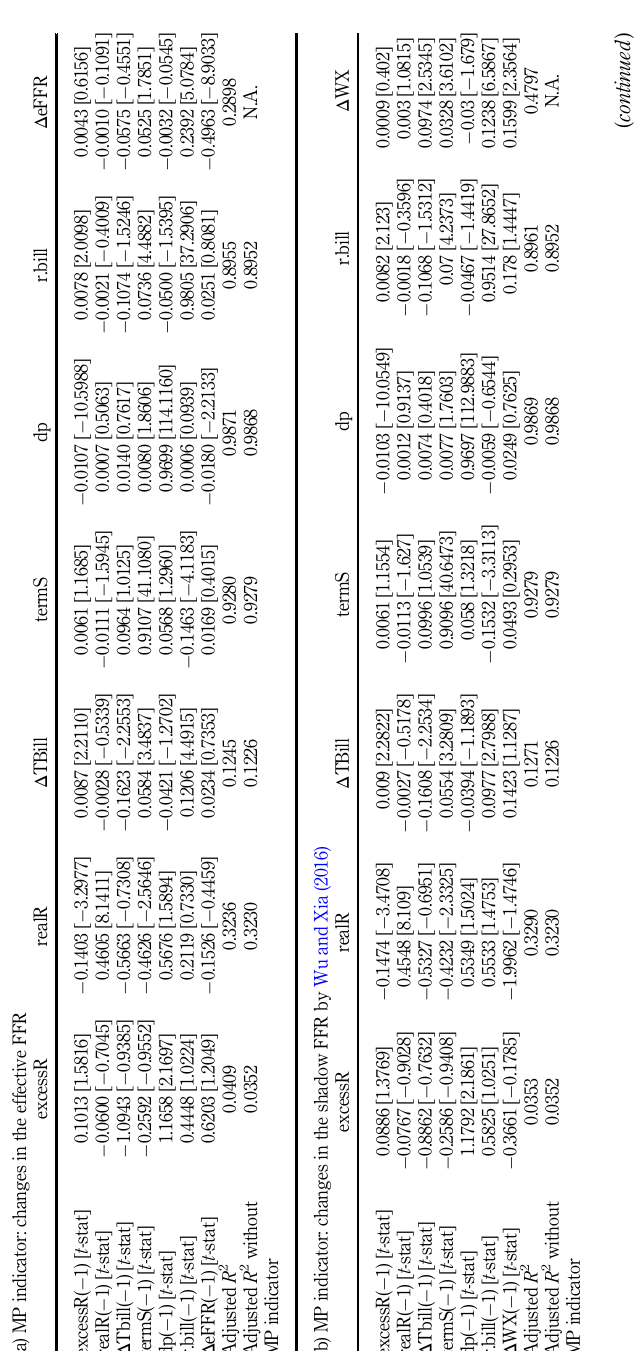
Table 3. Estimated coefficient matrix of